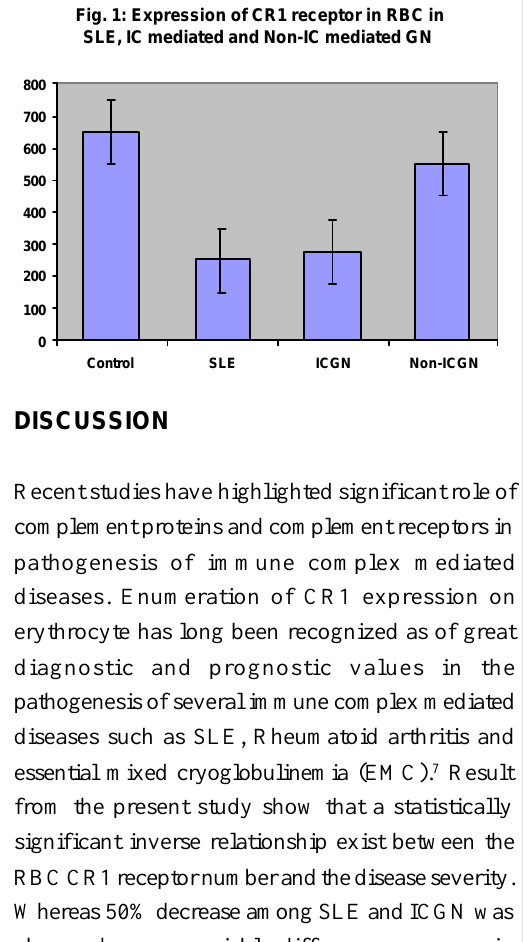
Table I : Serum complement level (C3, C4, CH100 and C3d) in SLE, IC mediated and non-IC mediated GN